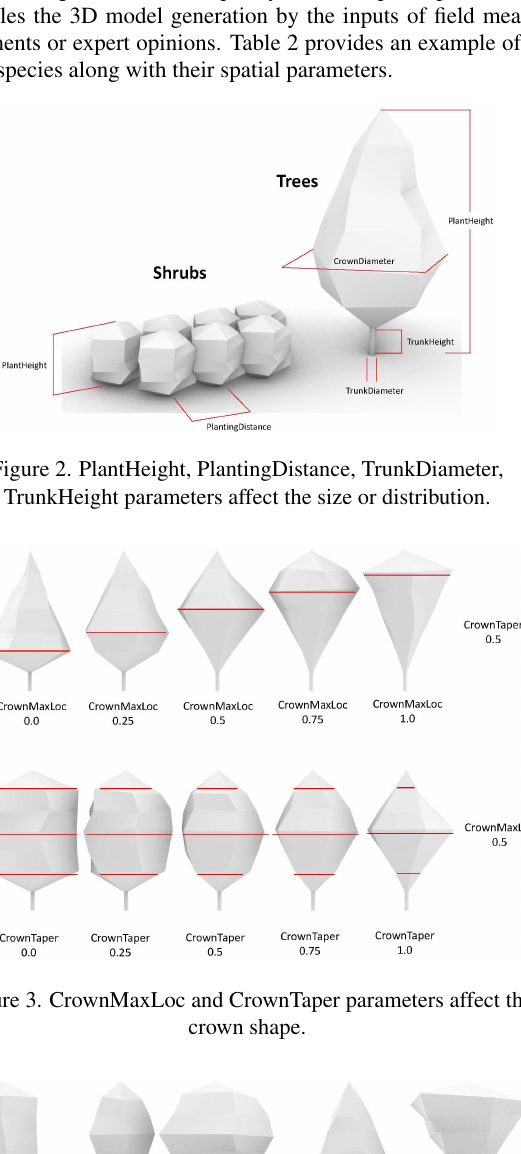
Figure 5. Placeholder objects exported as an IFC file for placing trees/palms (ground circle) and shrubs (ground